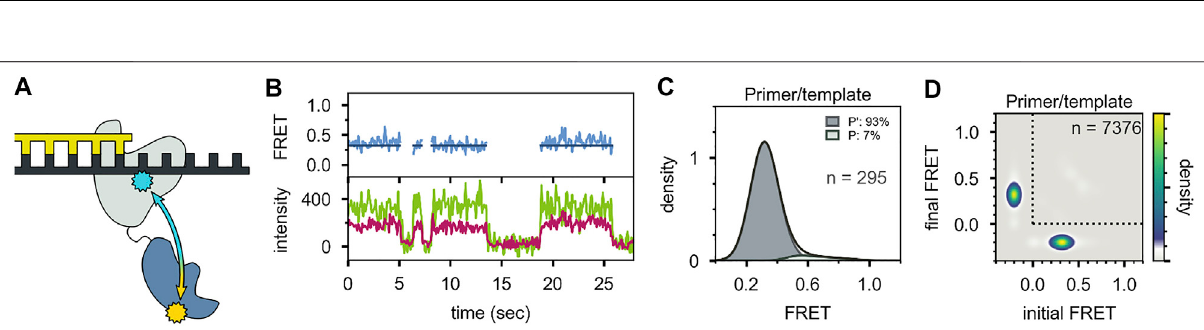
Frontiers in Molecular Biosciences |